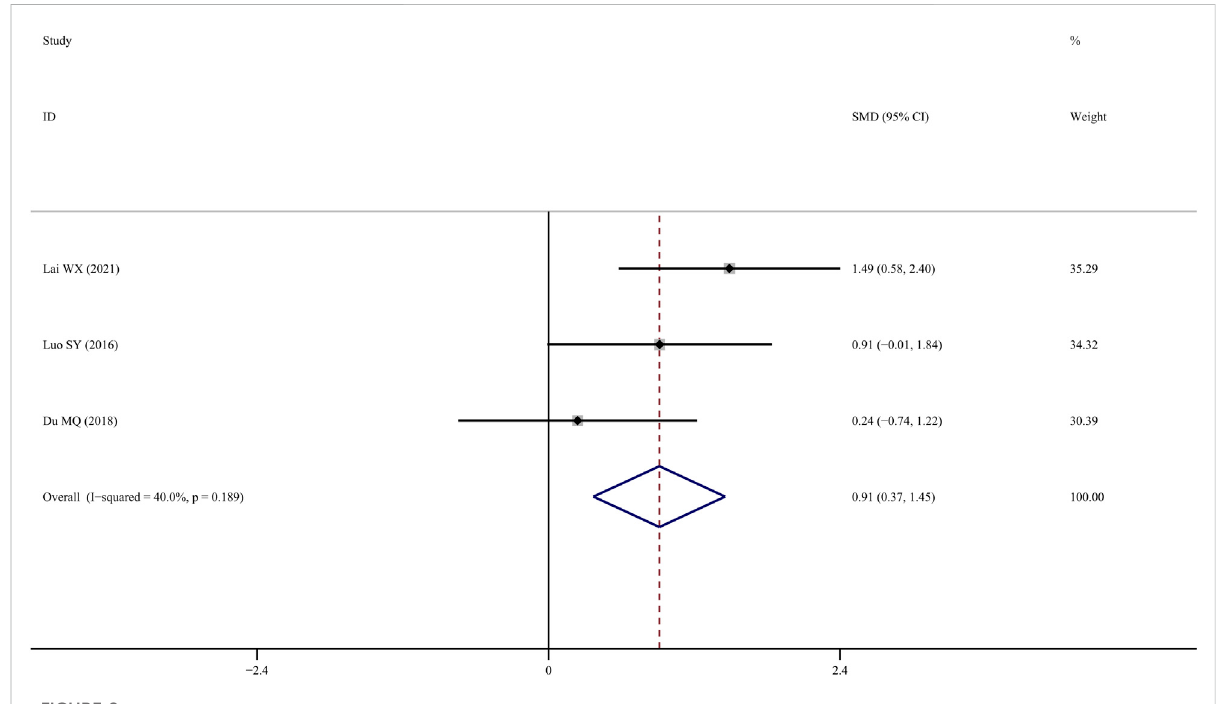
FIGURE 8 Effect of tanshinol on femur bone maximum load change in OP rats.